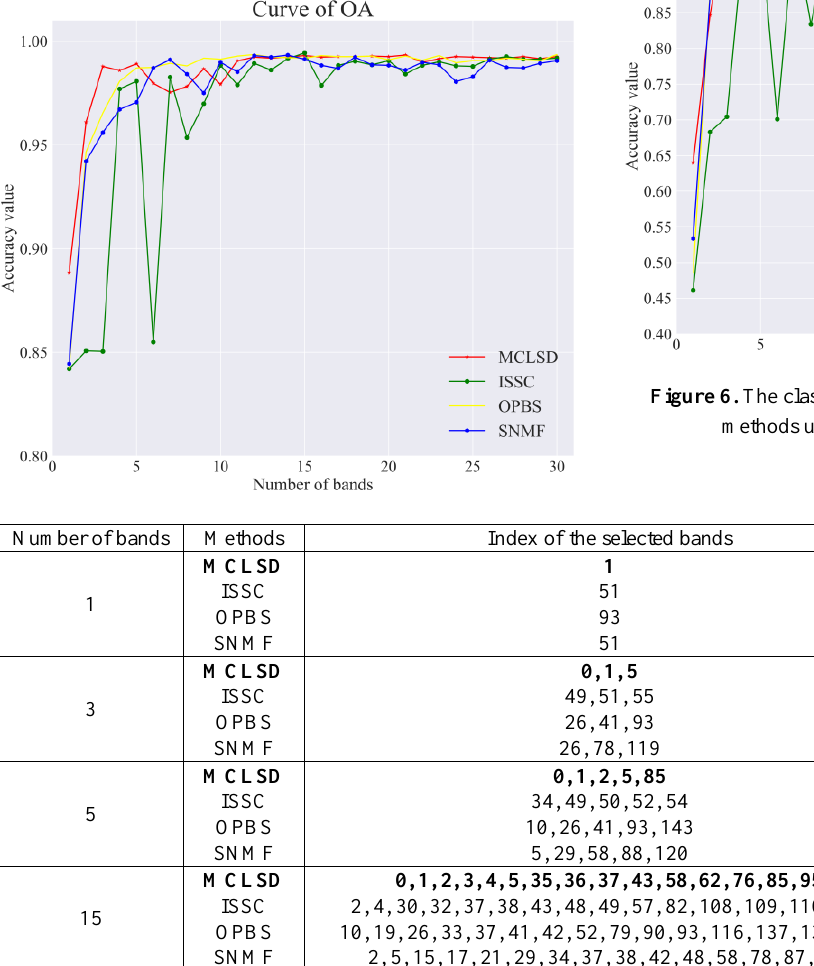
Table 2. The index of the selected bands and classification accuracy of the compared BS